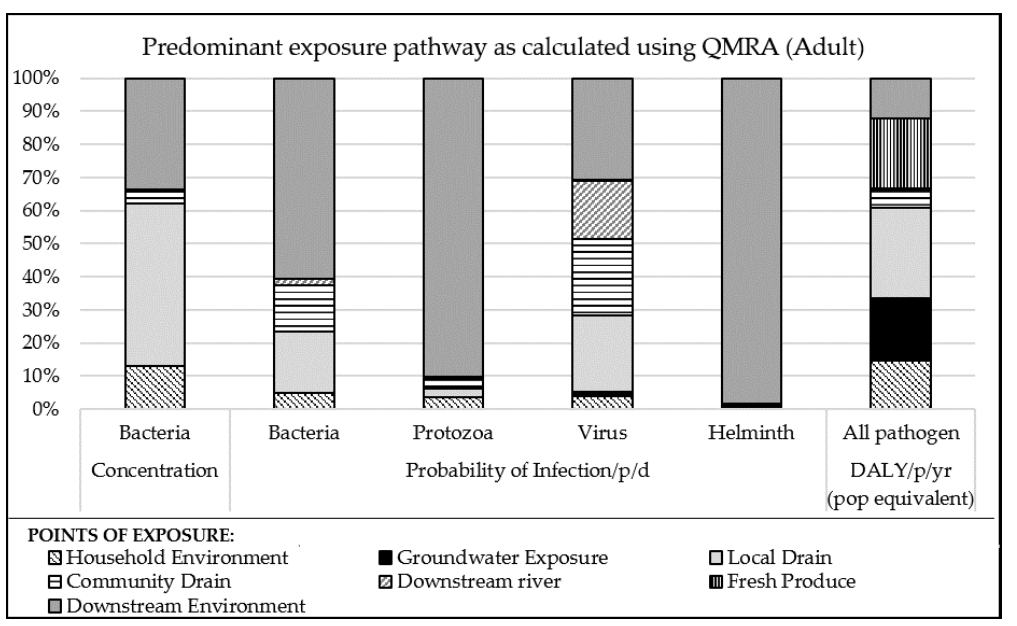
Figure 4. Illustrative outputs from the base case highlighting the importance of considering pathogens classes separately and calculating health risk in DALY to reveal priority points of exposure pathways.